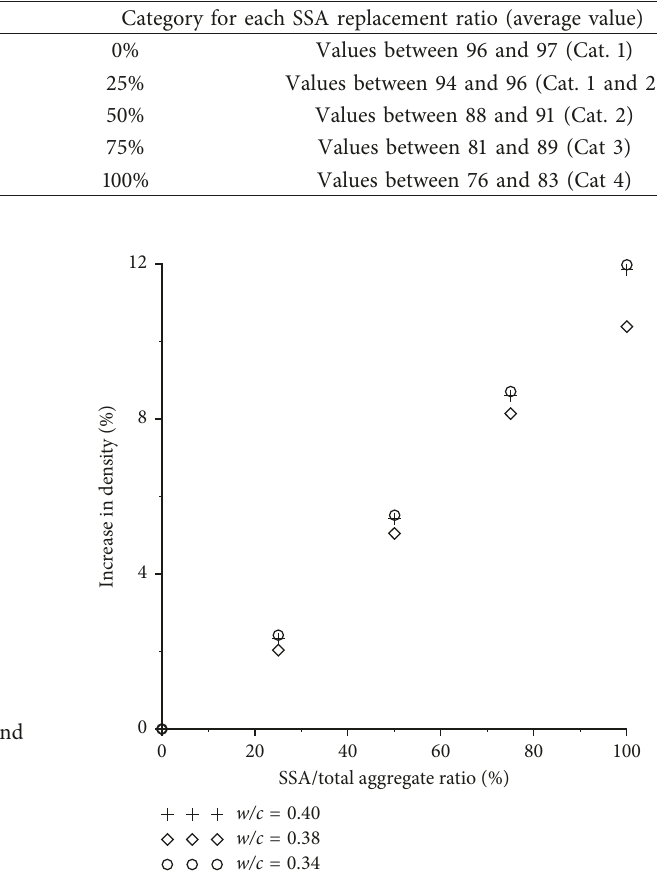
Figure 11: Relationship between the SSA replacement ratio and increase in density